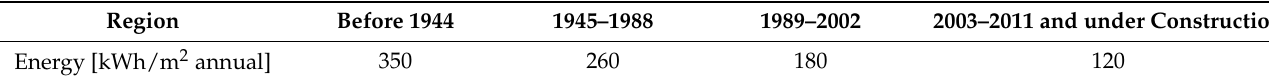
Table 3. Energy demand for heating a building depending on age. Region